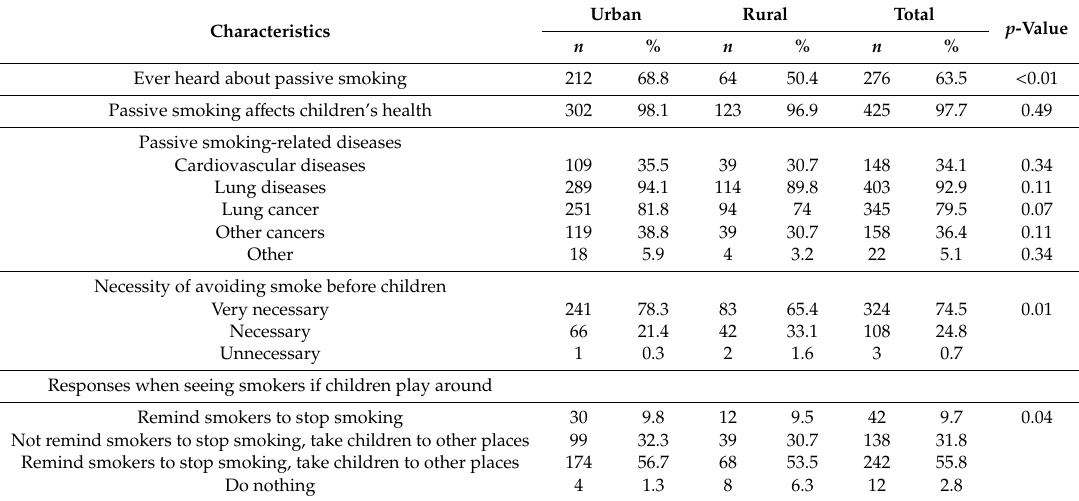
Table 3. Knowledge and attitude of caregivers on passive smoking exposure among children attending pediatric care